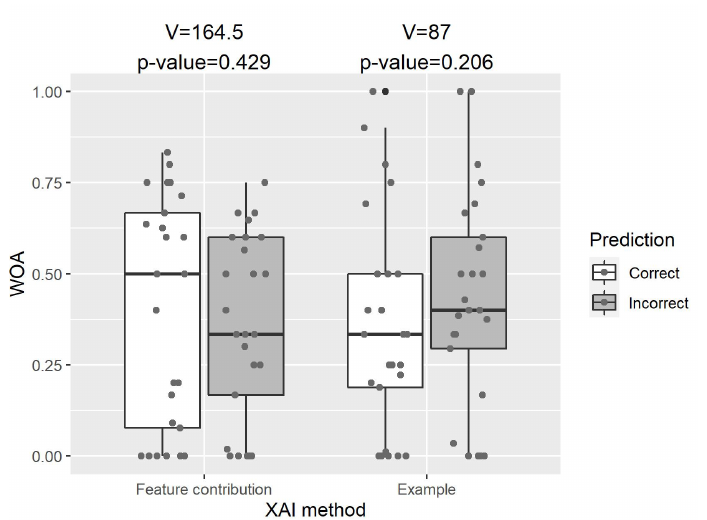
Figure 6. WOA for explanation by feature contribution and explanation by example for correctly and incorrectly predicted cases. Table 2. Comparison of WOA between correctly and incorrectly predicted cases for two XAI methods in subgroups of participants. Median is used as cutoff for continuous features (years of experience). No. of Feature